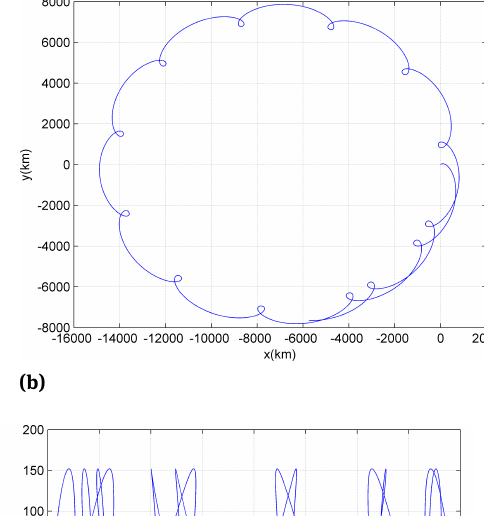
initial orbital elements of these debris objects are listed in Table 1. The initial positions and velocities of debris objects can be given in the inertia space, and are presented in